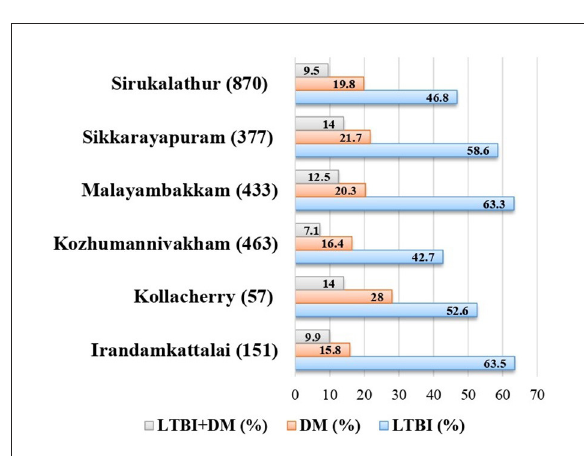
FIGURE2 Prevalence of LTBI and DM village wise. LTBI, latent tuberculosis infection; DM, diabetes mellitus.